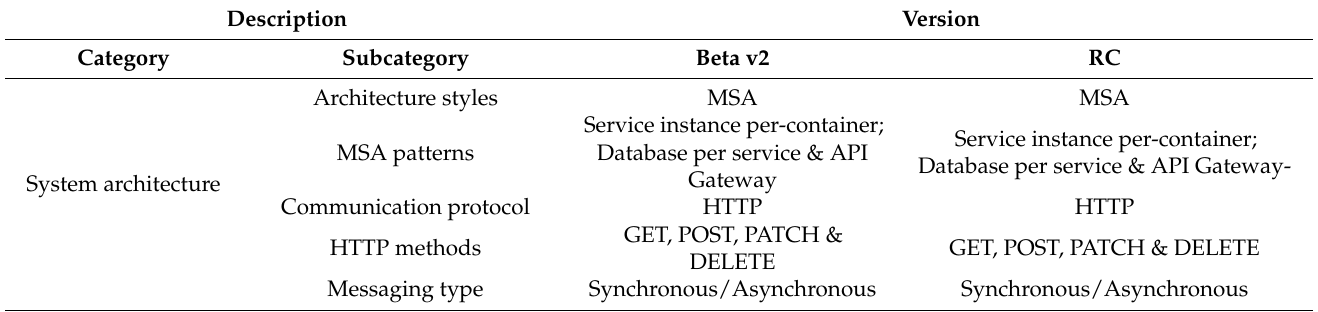
Table 2. General structure in the SPIDEP-MSA